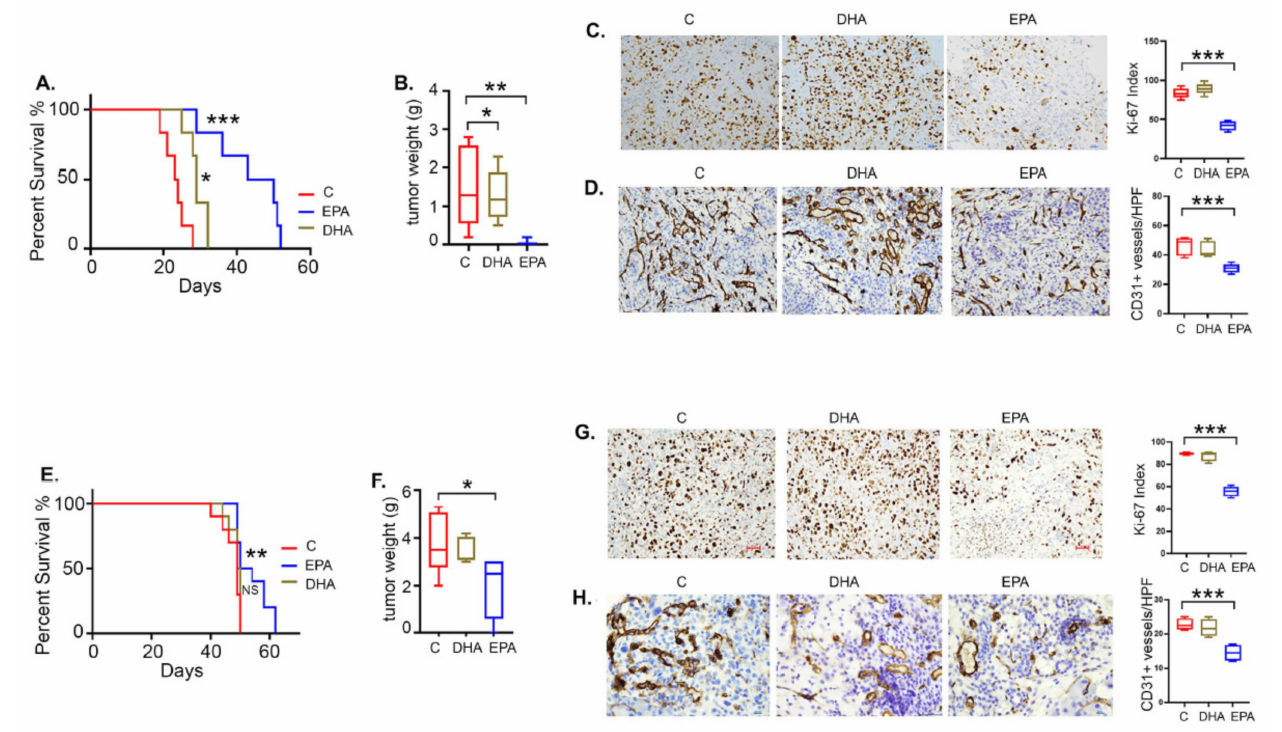
Figure 7. EPA and DHA inhibit ovarian cancer growth and improve survival. Mice injected in- traperitoneally with ( A ) CaOV3 and ( E ) SKOV3ip were treated with EPA or DHA and observed for survival ( n = 12), as described in the Materials and Methods section. Bar graph showing average tumor weights isolated from the ( B ) CaOV3 and ( F ) SKOV3ip mouse models ( n = 10 mice per group). Tumor sections from both groups were subjected to immunohistochemistry (IHC) for proliferation and neovascularization markers. Representative IHC images (200 × ) showing Ki67 stain in CaOV3 ( C ) and SKOV3ip ( G ) tumors. Box-plots show the Ki-index calculated from n = 5 images per group at high-power field (HPF). Representative IHC images (200 × ) showing CD31 stain in CaOV3 ( D ) and SKOV3ip ( H ) tumors. Box-plots show the number of positive vessels per field calculated from n = 5 images per group at HPF. * p ≤ 0.05, ** p ≤ 0.01, and *** p ≤ 0.001, respective treated